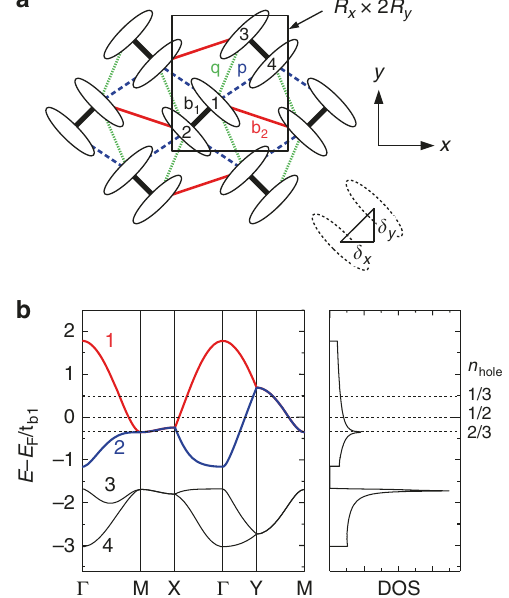
Fig. 1 Lattice and electronic structures of the model. a Two-dimensional lattice structure of κ -(ET) 2 X . Unit cell (black rectangle) contains four molecules labeled as 1 – 4 and its size is R x × 2 R y . Molecules are connected with bonds b 1 , b 2 , p , and q . The centers of the dimers (1 – 2 and 3 – 4) form an anisotropic triangular lattice. b Band structure and density of states (DOS) of κ -(ET) 2 Cu[N(CN) 2 ]Br. E F denotes the Fermi energy for n hole = 1/2 (undoped case). Dotted lines correspond to the Fermi energy for n hole = 1/ 3, 1/2, and 2/3. High symmetry points of momentum k are Γ (0,0), M( π / R x , π /2 R π / R π /2 R y ), X( x ,0), and Y(0, y ) (See also Fig.